Question: Provide a one-line summary of what is displayed.
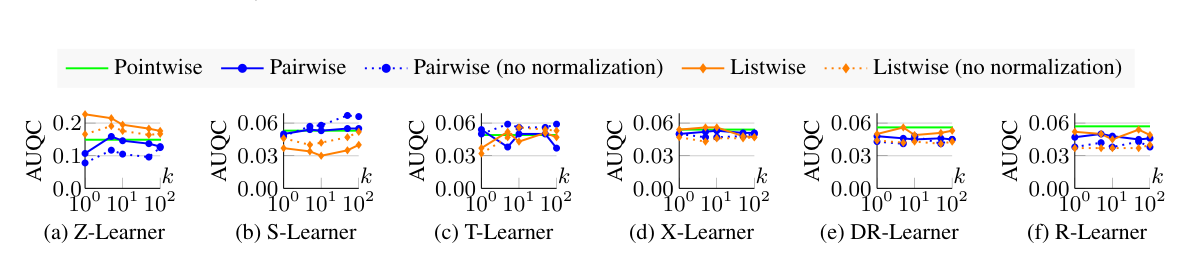
Answer: What Is the Effect of the Number of Sampling Iterations k? We show performance in terms of AUQC for the different metalearners on the Synthetic data set. We fix the sigmoid parameter σ = 1 and train with default hyperparameters.